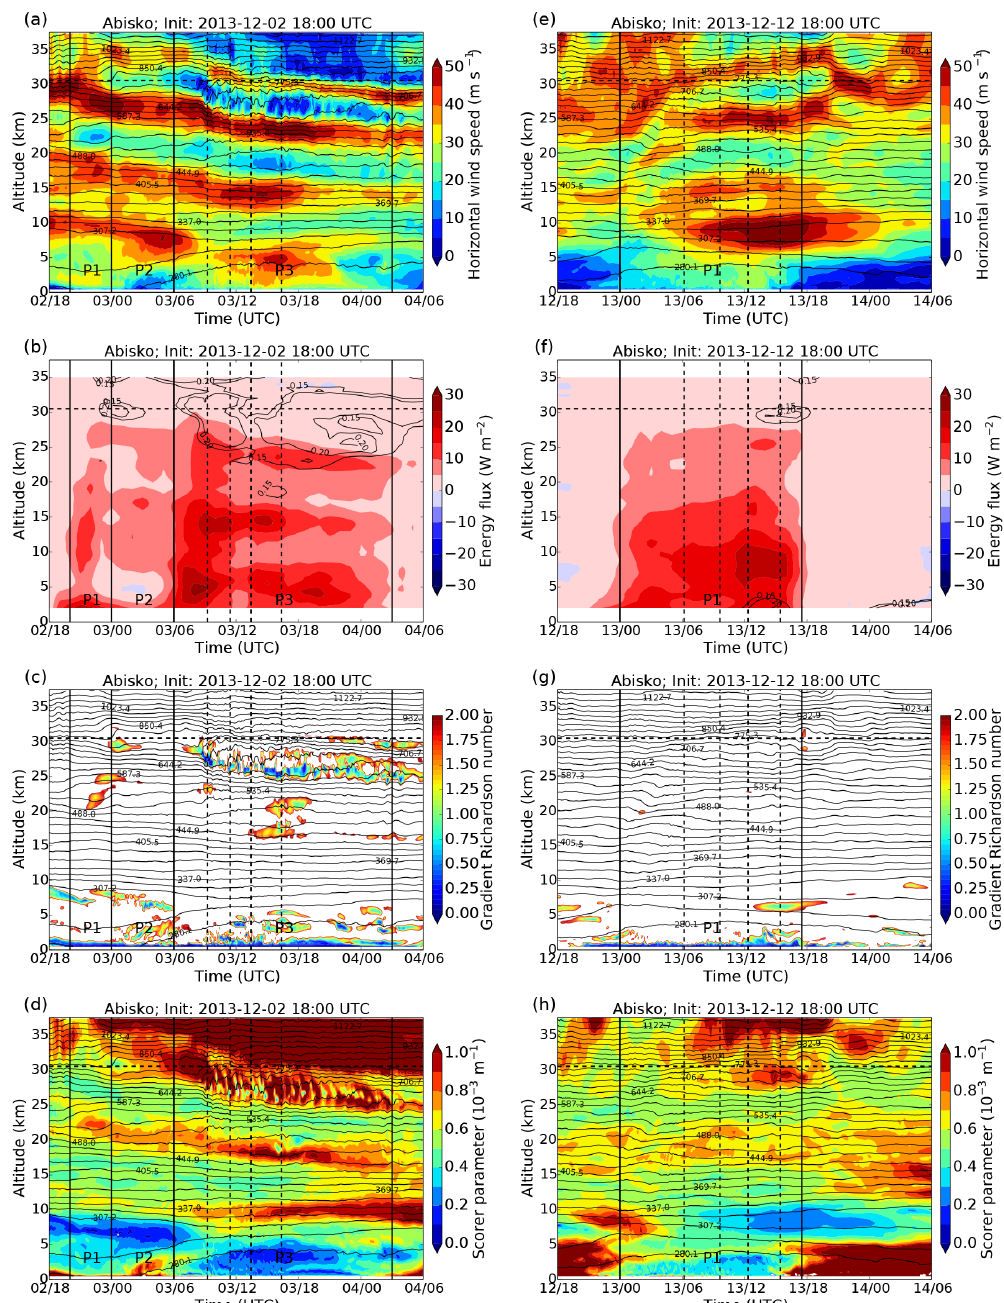
Figure 5. Vertical time series of CTRL D2 simulations at Abisko (68 ◦ N, 19 ◦ E) during (a–d) IOP1 and (e–h) IOP5 for horizontal wind speed, vertical energy flux, gradient Richardson number and Scorer parameter. The vertical solid and dashed lines mark the different mountain wave phases and periods of research flights. The dashed horizontal line indicates the height of the sponge layer at the model top. Thin black contour lines mark the nonlinearity ratio (NLR) of Kruse and Smith (2015) in panels (b) and (f) and isentropes in the remaining figures.